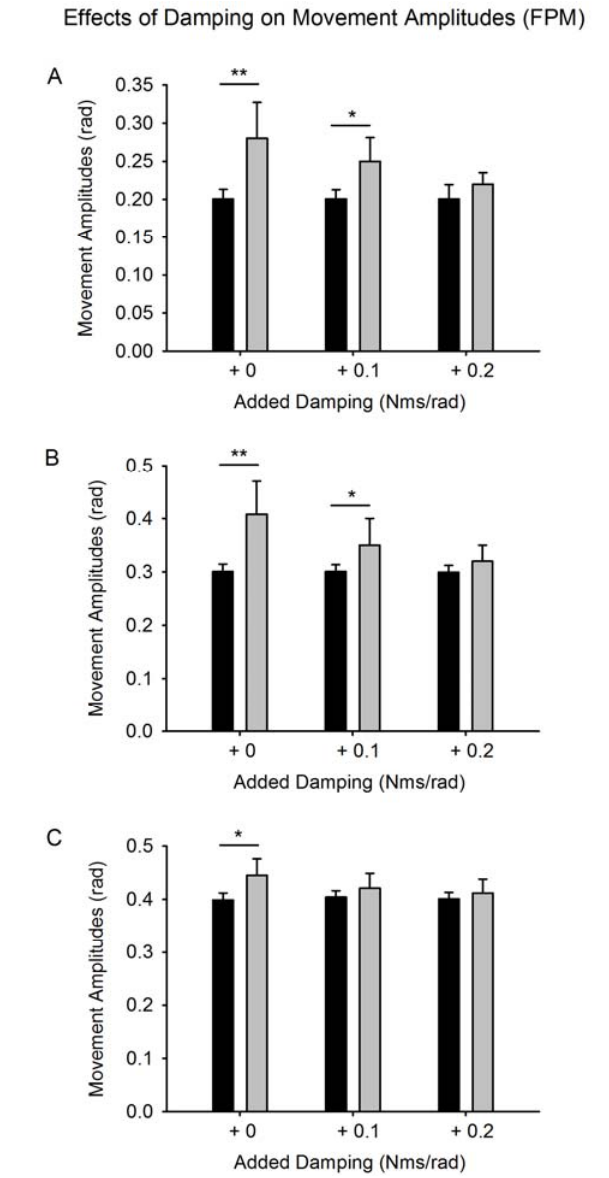
(FPM). Aimed target: 0.2 rad, 0.3 rad and 0.4 rad, respectively in A, B and C. Values are mean ±SD. Black columns: control subjects, grey columns: cerebellar patients. *: p < 0.05; **: p <